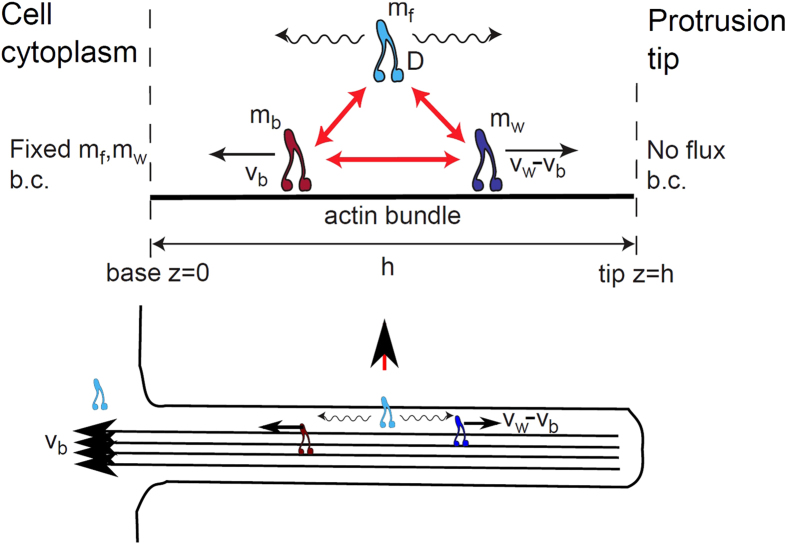
Illustration of a one-dimensional model of motors inside a linear protrusion, moving along unipolar filaments.Free motors (light blue) diffuse (with diffusion coefficient D), bound motors (red) drift towards the protrusion base at the treadmilling velocity vb, and processively walking motors (blue) with velocity vw − vb towards the tip. Reversible transitions are assumed between all states (red arrows).